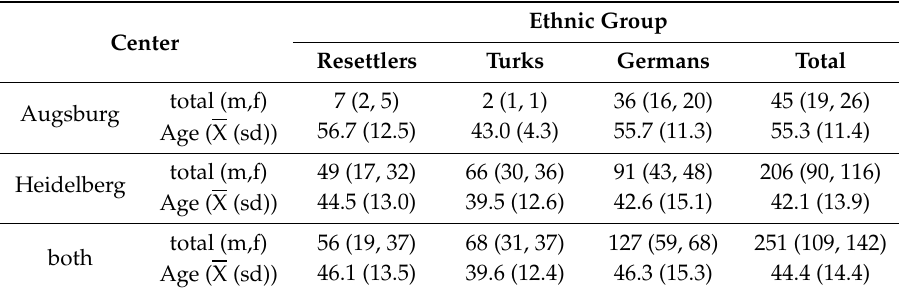
Table 1. Center, sex, and age distribution by ethnic groups.